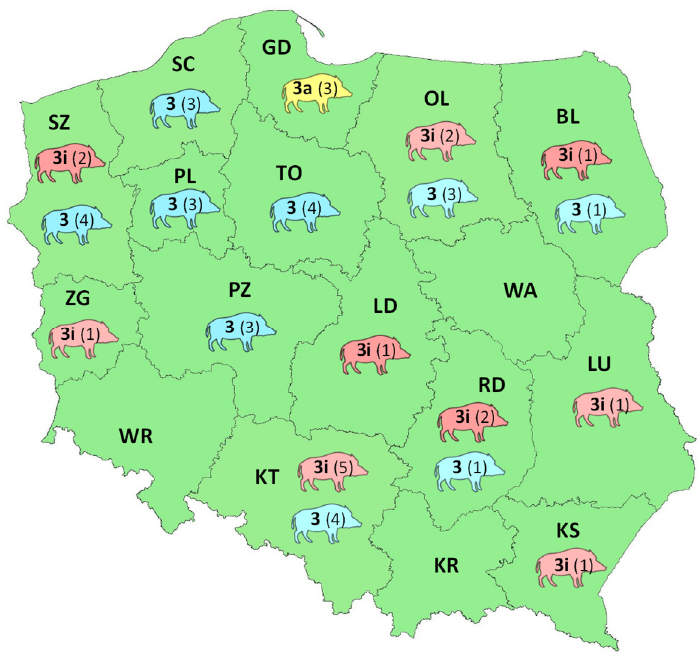
Figure 2. The regional distribution of HEV subtypes and the number (in brackets) of detected HEV strains across Polish RDSFs. The colors denote different virus subtypes (red—3i, yellow 3a, blue—HEV-3 strains not assigned to any virus subtype).